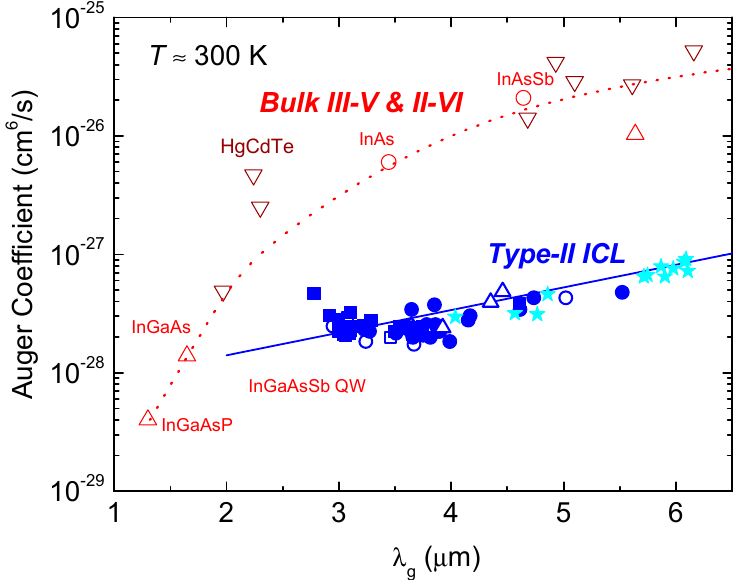
Figure 24. Three-dimensional Auger coefficients, normalized from the 2D values as discussed in the text, extracted from experimental room-temperature pulsed threshold current densities for broad-area (150 μ m × 2 mm) ICLs processed from 70 different wafers with 3, 5, 7, and 10 stages grown at NRL, as a function of emission wavelength. Three-dimensional values for various III-V and II-VI bulk materials are also shown for comparison.